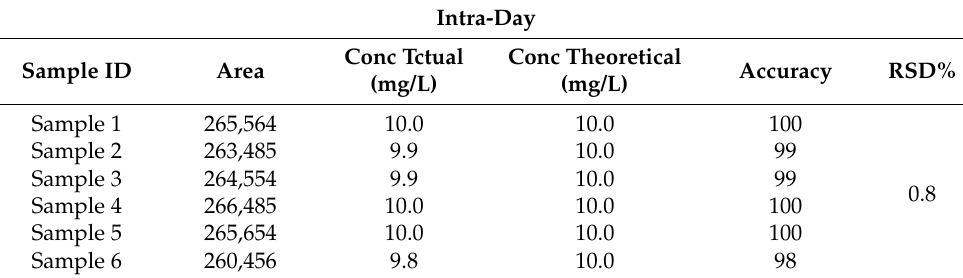
Table 4. Intermediate precision (Intra-day) of pantoprazole.